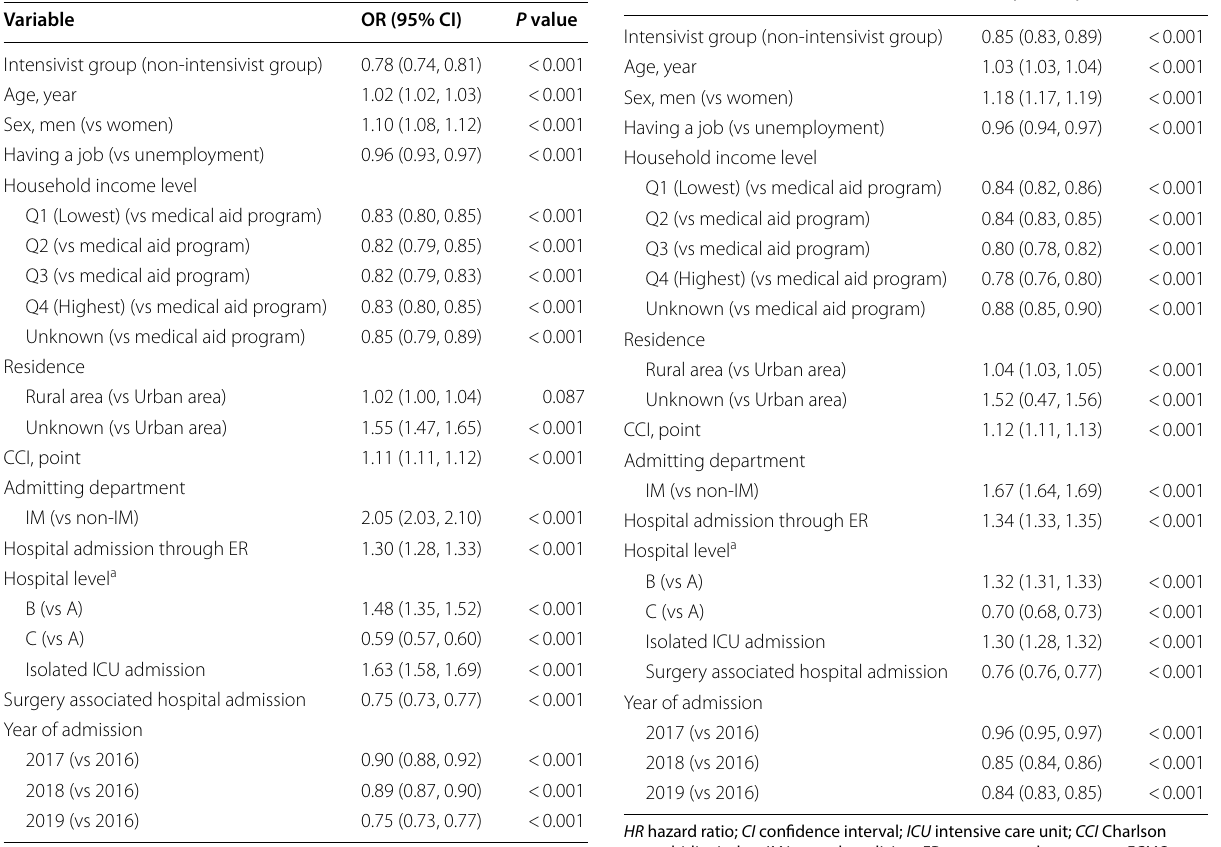
Table 2 Mixed effect logistic regression model for in‑hospital mortality